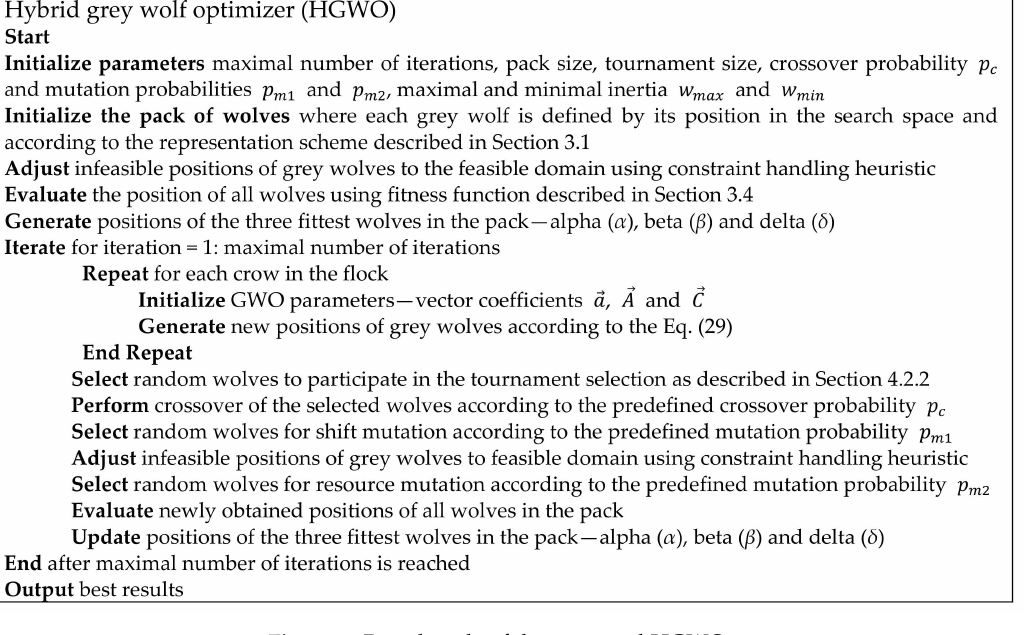
Figure 7. Pseudocode of the proposed